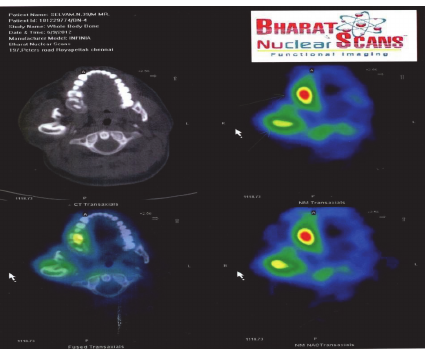
Figure 6: Bone scintigraphy shows increased uptake and hyperac- tivity in right sided maxilla and mandible of the